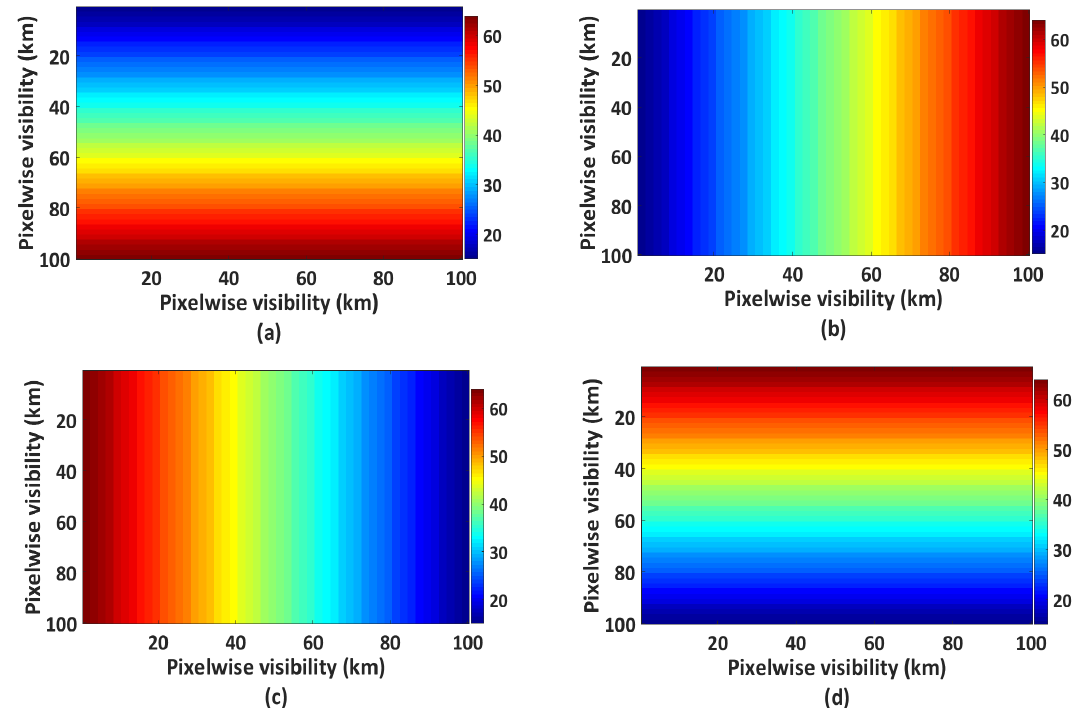
Figure 13. Pixelwise perturbation to the spatial variability of visibility with ( a ) 90 ◦ rotation; ( b ) no rotation; ( c ) 180 ◦ rotation; and ( d ) 270 ◦ rotation.